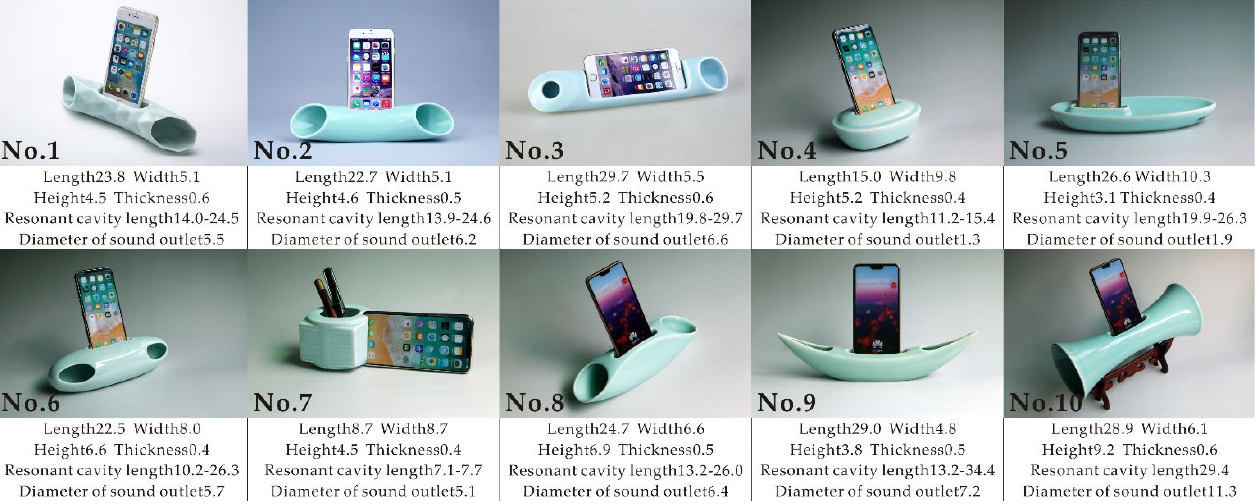
Figure 1. Details of experimental parameters of samples of ceramic mobile passive amplifiers (unit: cm).